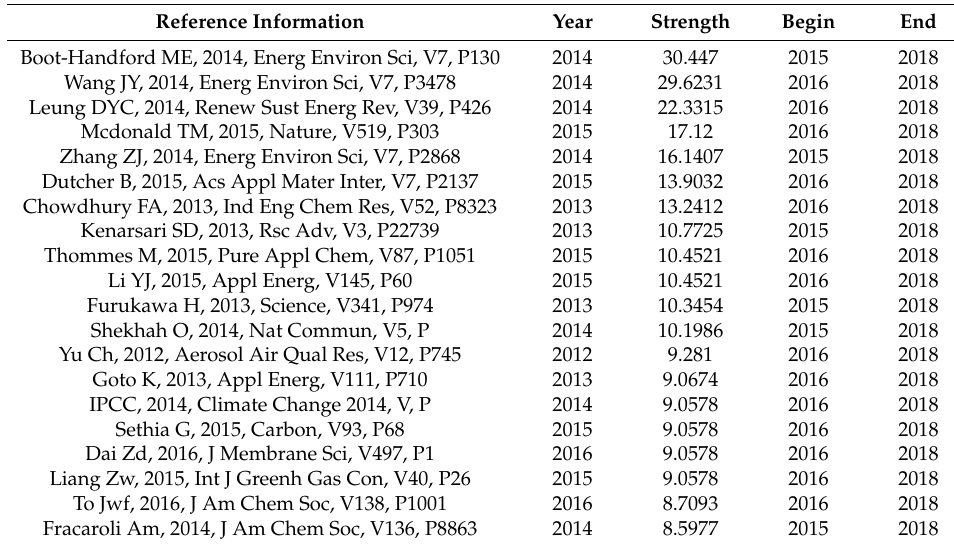
Table 5. Top 20 literature with strongest citation